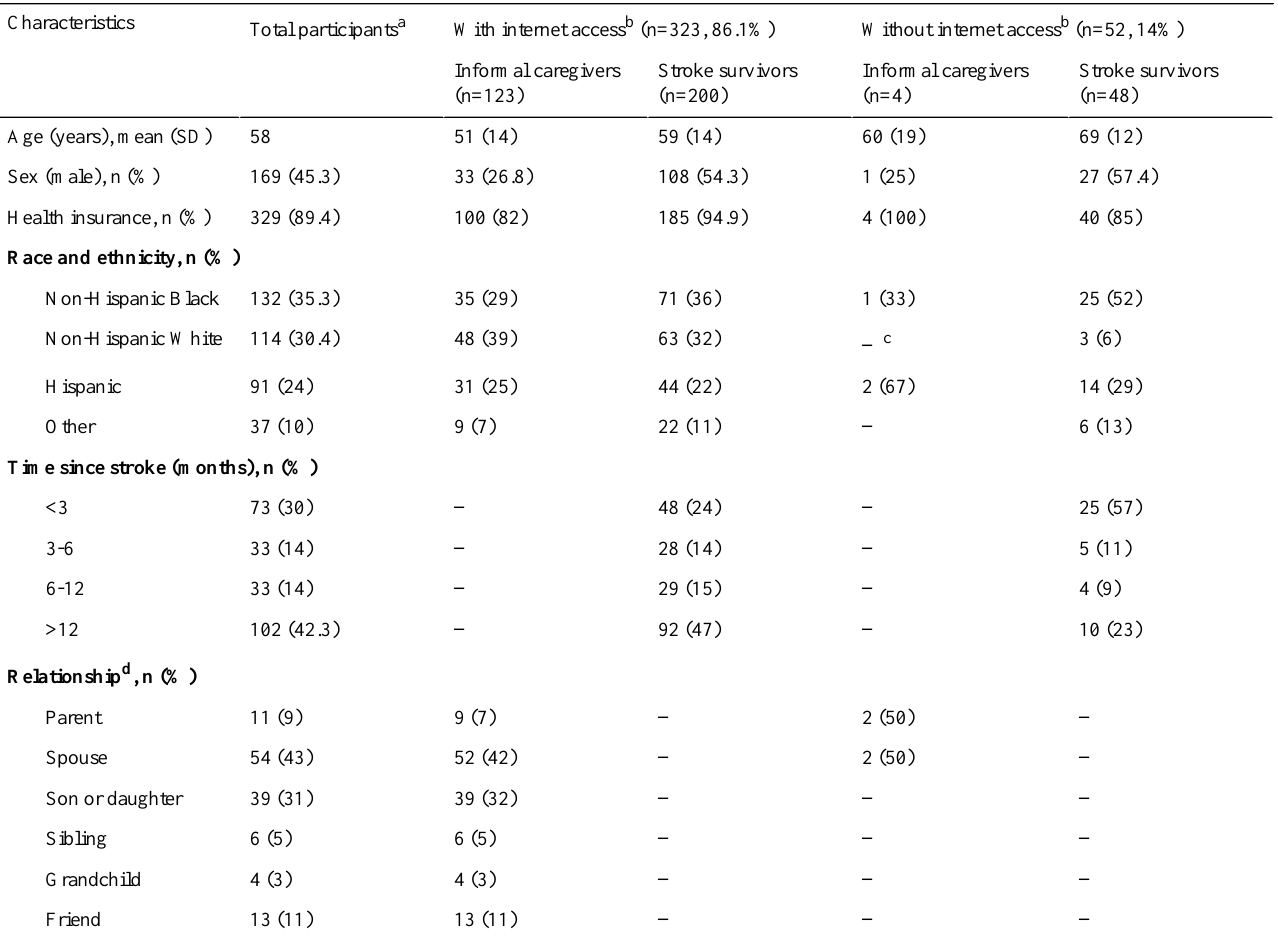
Table 1. Comparison of demographic characteristics of stroke survivors and informal caregivers (N=375) by internet access.